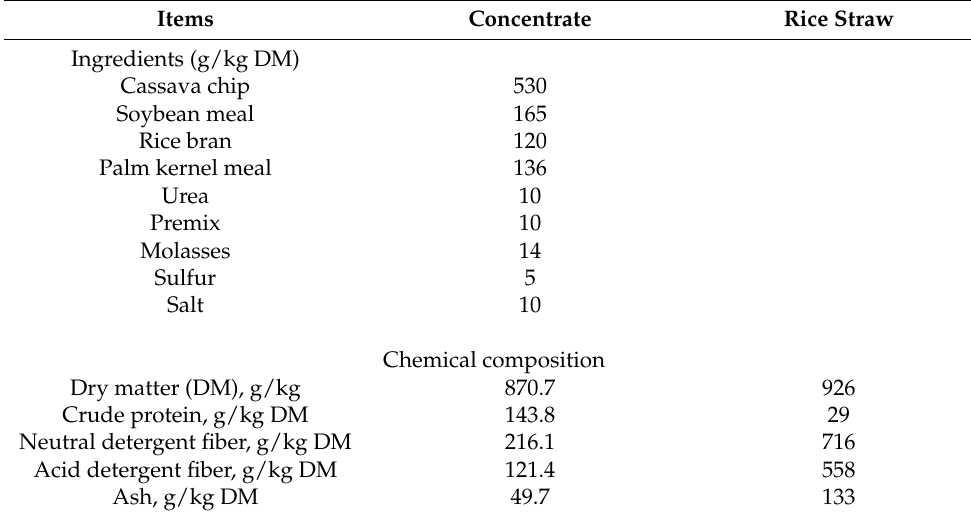
Table 1. Ingredients and chemical composition of substrate used in this study.